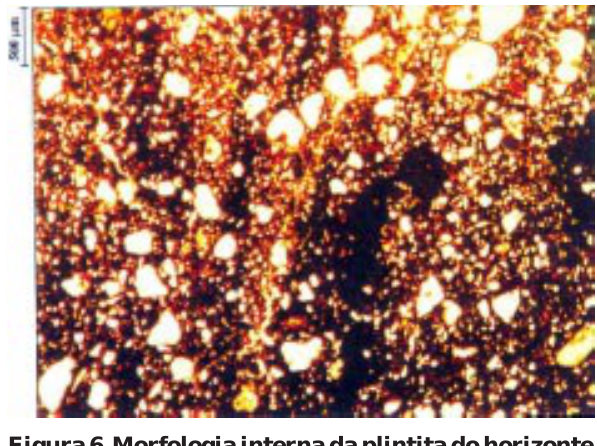
6. Morfologia interna da plintita do horizonte Cf (perfil P1) mostrando volumes mais claros rela- cionados com as porções amareladas e anisotró- picas sob microscópio ótico. Luz normal - 2,5x.